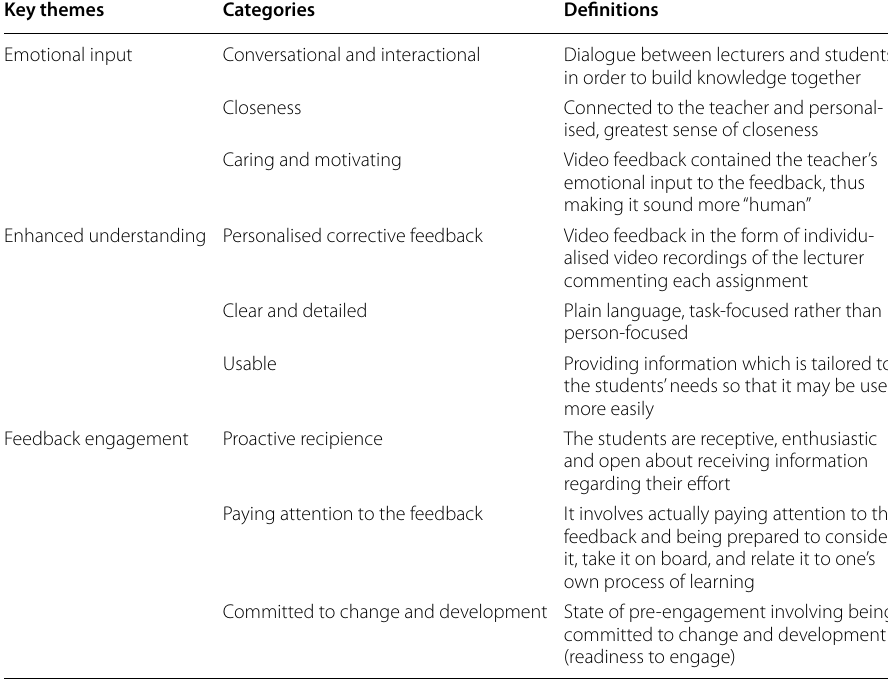
Note: The definition of the themes and categories is based on previous literature